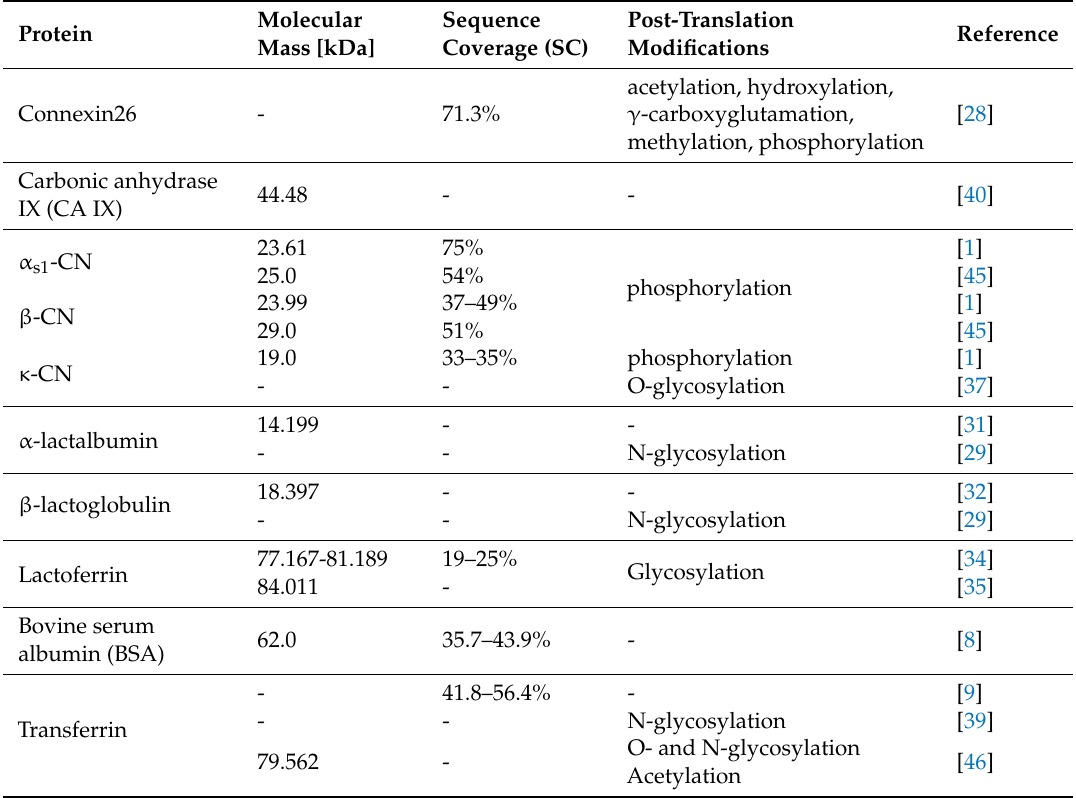
Table 1. Short-review of matrix-assisted laser desorption/ionization with time-of-flight mass spectrometry (MALDI-TOF MS) methods used for the identification and analysis of different proteins. Molecular Sequence Post-Translation Protein Mass [kDa] Coverage (SC) Modifications